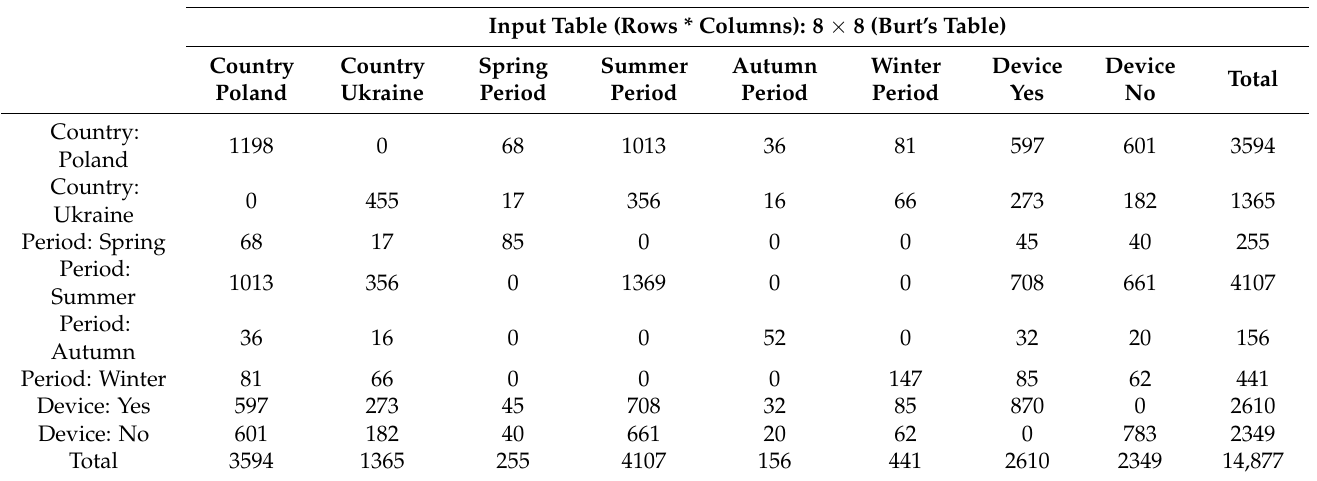
Table 6. Distribution of frequency profiles observed among respondents regarding country, period of use of the largest amount of tap water supplied and the use of an additional device to filter and/or treat tap water. Frequencies Observed Input Table (Rows * Columns): 8 × 8 (Burt’s Table)